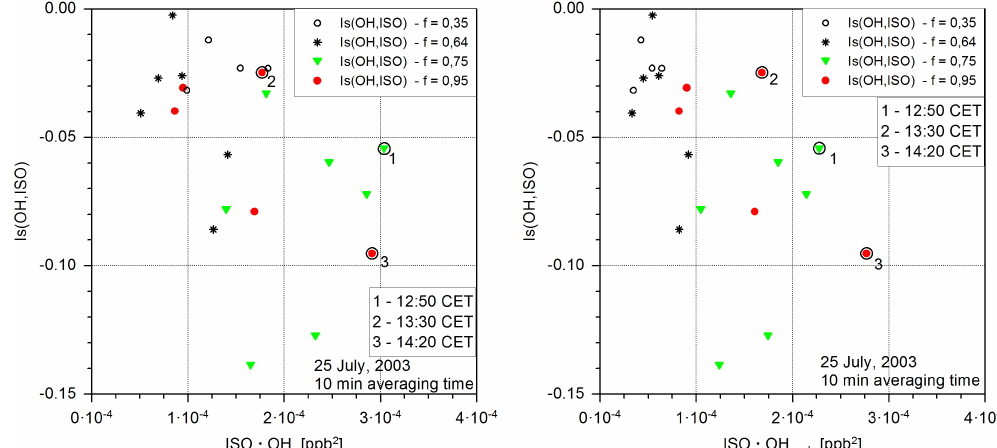
Figure 13. The intensity of segregation as a function of the product of mixing ratios of isoprene and OH and OH mod for different classes of factor f . The three data points 1–3 are explained in Sect. 5.3.2.